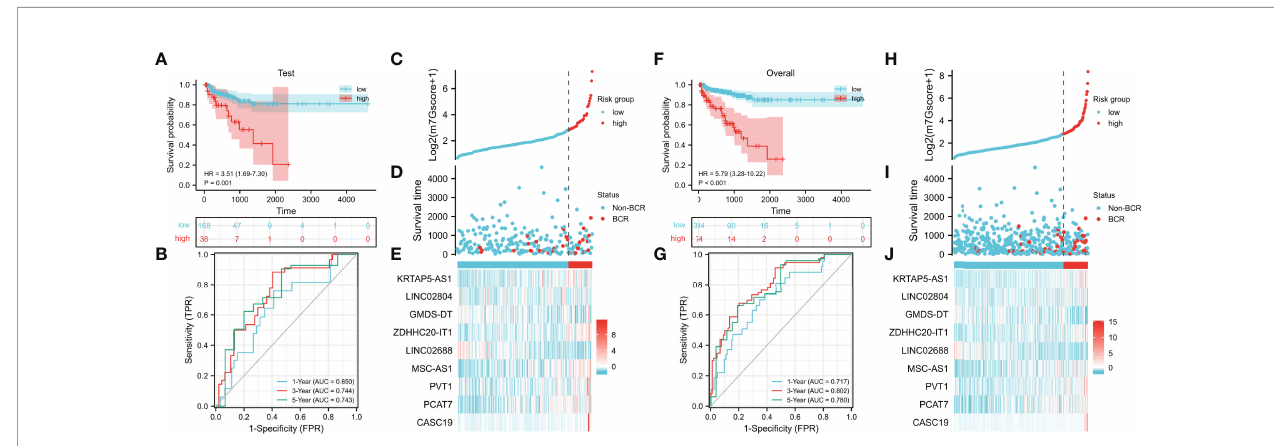
FIGURE 4 | Validation of the m7G model. (A, B) Evaluation of the m7G model with Kaplan – Meier analysis (A) and time-dependent ROC curves (B) in the test set. (C – E) Distribution of m7Gscore (C) , BCR status (D) , and model consisting of m7G-related lncRNAs (E) in the test set. (F, G) Evaluation of the m7G model with Kaplan – Meier analysis (F) and time-dependent ROC curves (G) in TCGA cohort. (H – J) Distribution of m7Gscore (H) , BCR status (I) , and model consisting of m7G-related lncRNAs (J) in TCGA cohort. m7G, 7-methylguanosine; ROC, receiver operating characteristic; BCR, biochemical recurrence; TCGA, The Cancer Genome